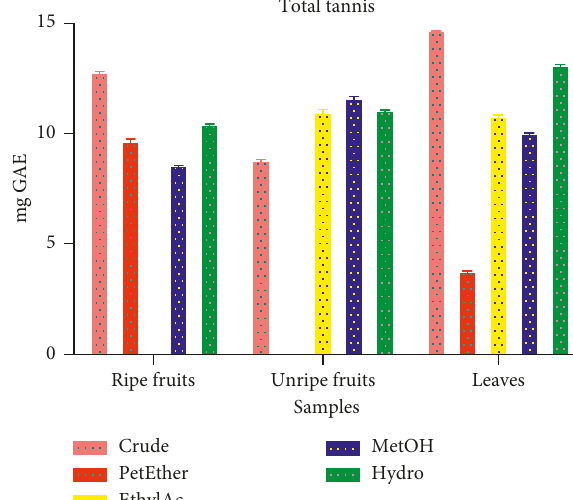
Figure 4: Total phenolic content of extract and fractions of D. erecta .